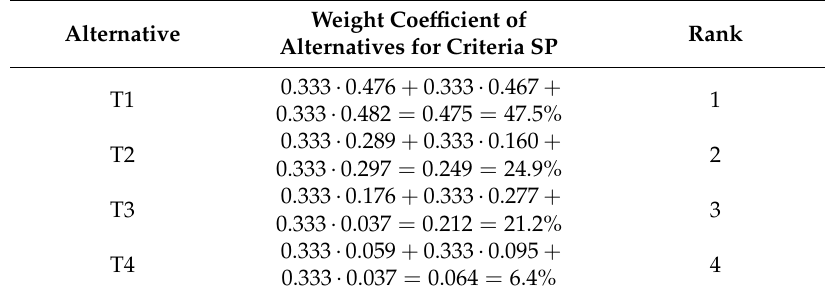
Table 15. Ranking by survey criteria.